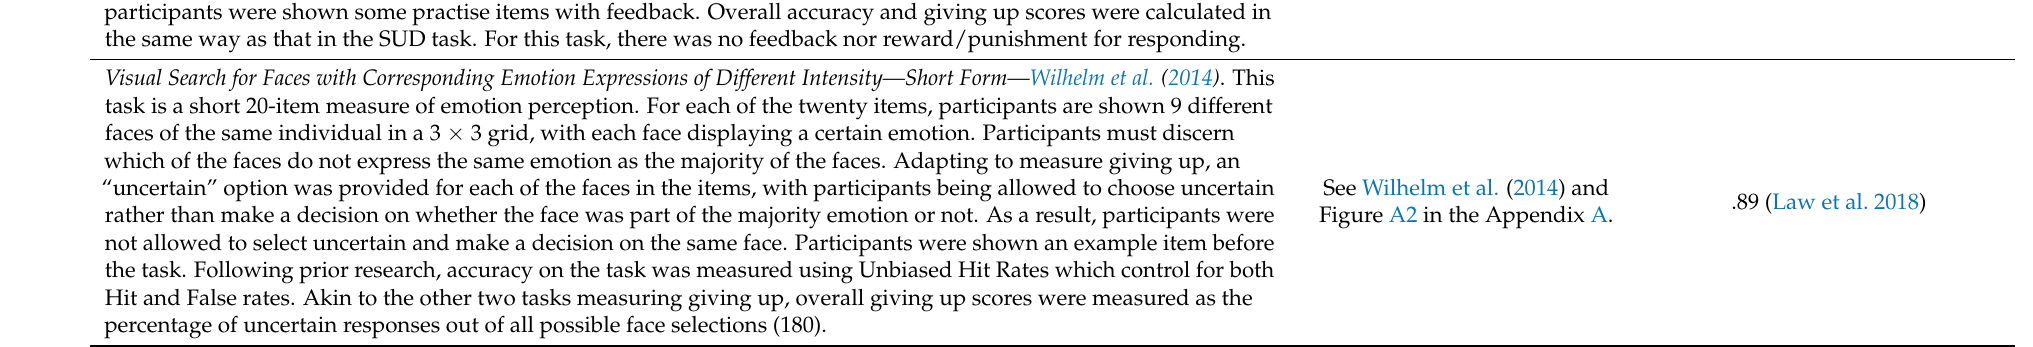
(Kozhevnikov and Hegarty